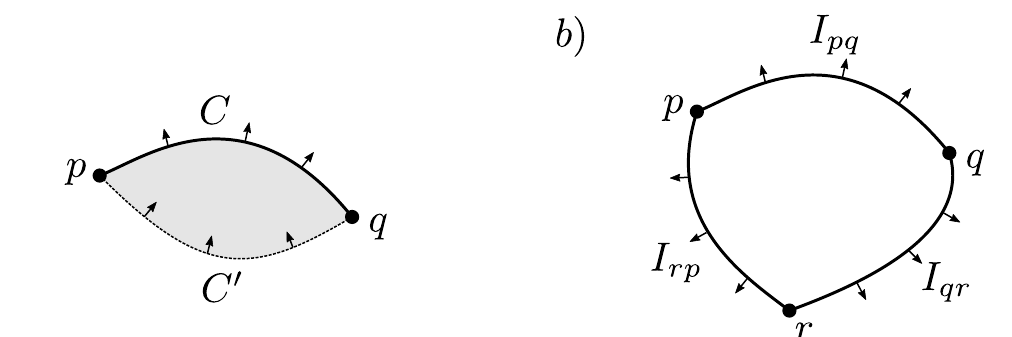
Figure 4: a) Schematic depiction of the argument showing that time-averaged cur- rent through a cut C between to plaquettes p and q only depends on the cut’s two end-points. Specifically, since there can be no accumulation of charge over time in the region between the cuts C and C (cid:48) , the same current must pass through the two = ¯ I cuts, and thus ¯ I for any two cuts C and C (cid:48) between the plaquettes p and q . b) C C (cid:48) + I = I The vanishing divergence of current implies that I pq qr pr